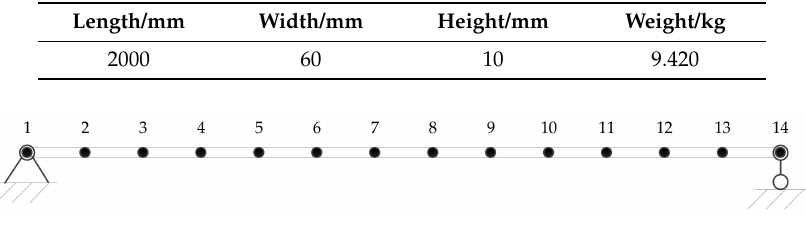
Figure 13. Locations on the experimental beam for the distribution of sensors and the position